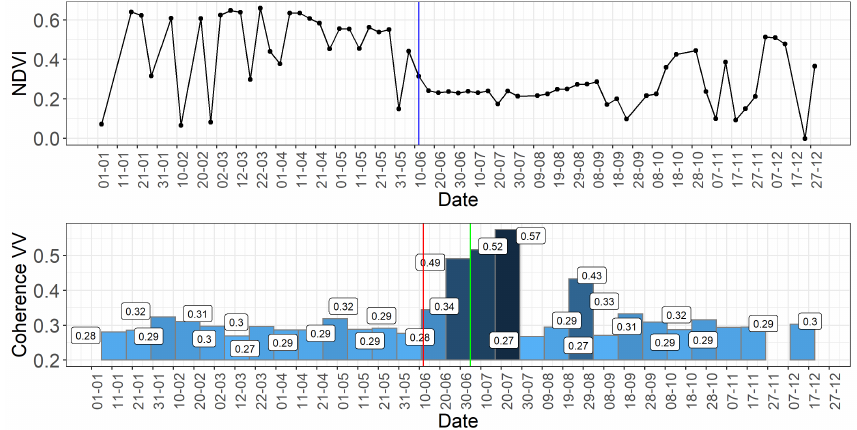
Figure 19. Example of the harvest date omission by the SAR algorithm due to nonagricultural lands within the parcel (cid = 40). Actual harvest date (red lines): 12 June 2018; harvest date according to the optical algorithm (blue lines): 12 June 2018; harvest date according to the SAR algorithm (green line): 5 July